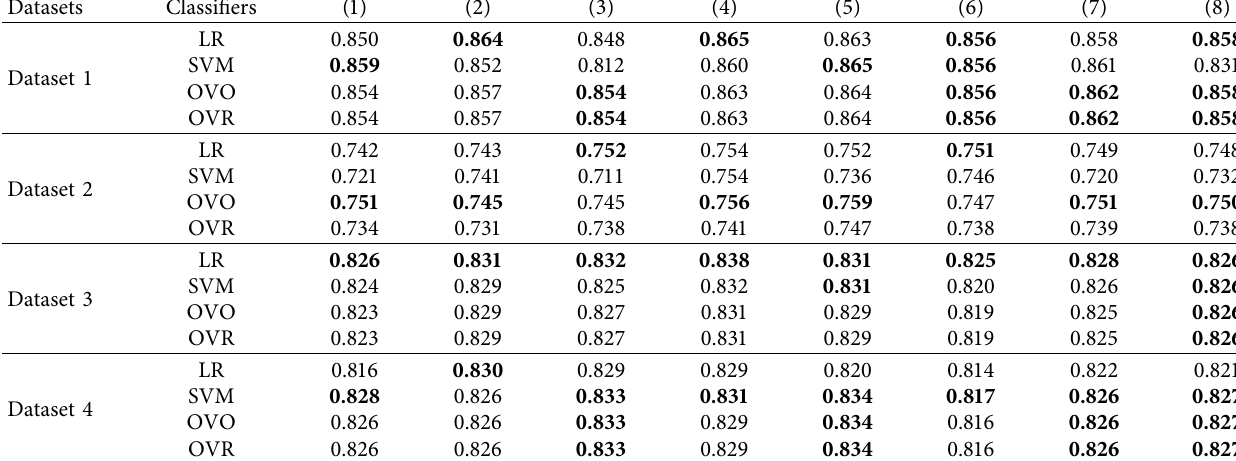
Table 3: The accuracy results of various data augmentation techniques for Vietnamese sentiment analysis based on machine learning classifiers.